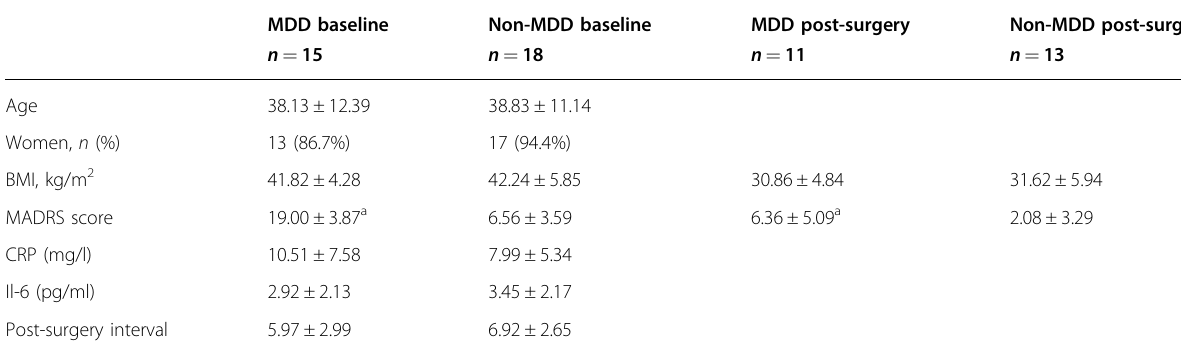
All data are mean ± SD unless indicated. BMI body mass index, CRP plasma C-reactive protein, IL-6 plasma interleukin-6. a Indicates a statistical difference between MDD and non-MDD patients by t